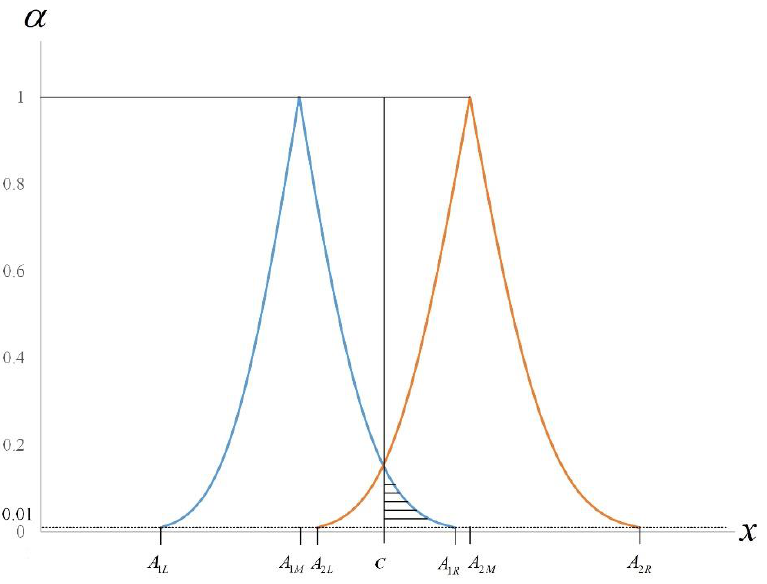
() x  before improvement and fuzzy 1